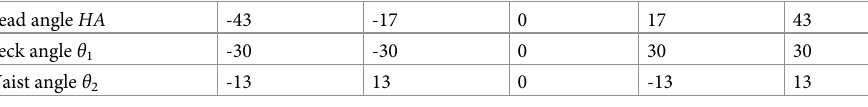
Table 1. The relationship among head angle, the neck, and waist joint. Head angle HA -43 -17 0 17 43 Neck angle θ 1 -30 -30 0 30 30 Waist angle θ 2 -13 13 0 -13 13 All angles are shown in